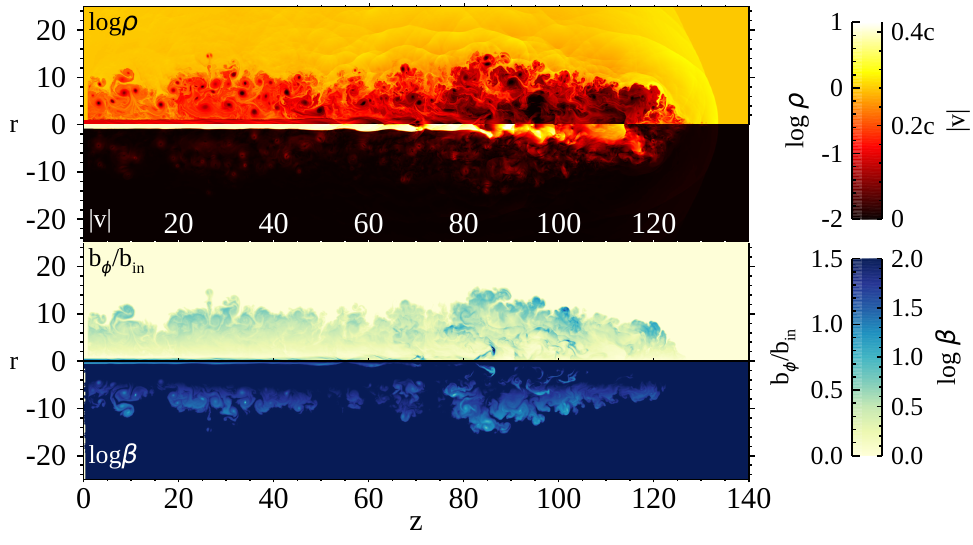
Figure 1. Top to bottom: The gas density, the jet absolute velocity, the toroidal magnetic field normalized by the injection field b in , and plasma β for model TWC at t = 70 t 0 .